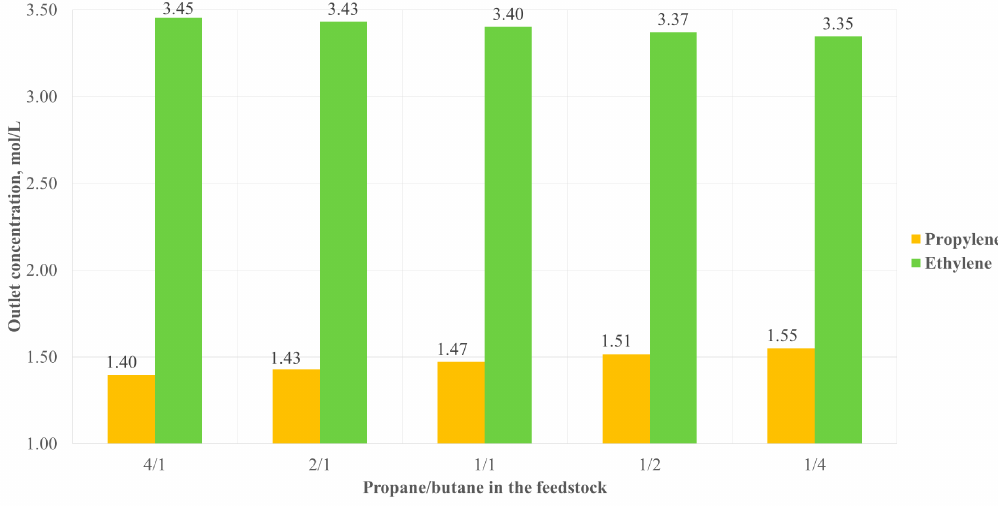
Figure 9. Influence of propane/butane ratio in the feedstock on the yield of propylene and ethylene.